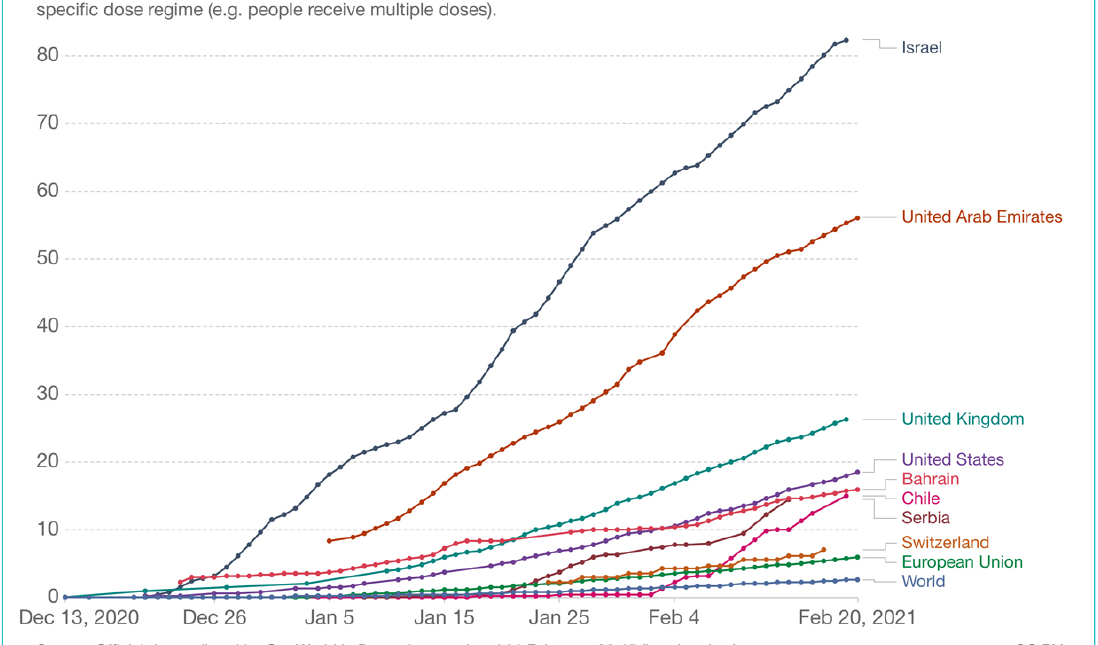
Figure 2: Cumulative COVID-19 vaccination doses administered by